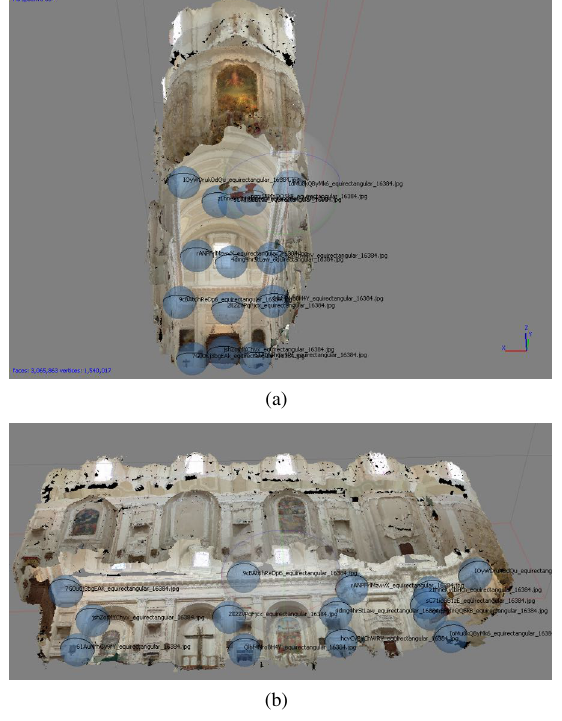
Figure 7. The interior of the Church after the creation of the dense point cloud and 3D mesh, with the application of textures.